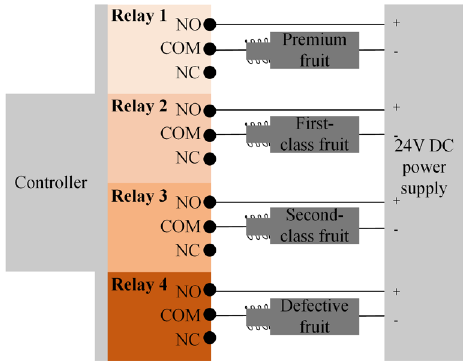
Figure 10. The composition of the hardware system.